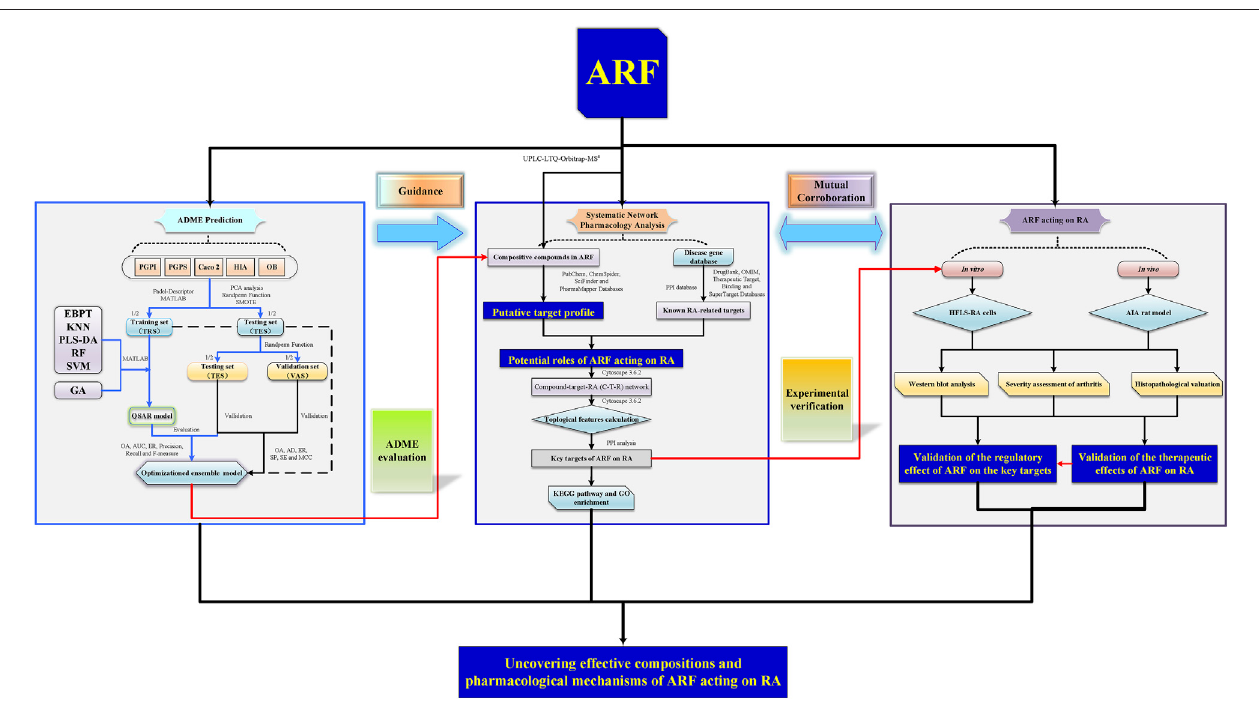
FIGURE1| AschematicpictureofthewholedevelopmentstrategiesinunravelingthepharmacologicalmechanismsofARFderivedfromDianbaizhuintreatingRA. FortheADMEpredictionsection,thebluesolidarrowsrepresentthemodelingprocessoftheQSARmodels,andtheblacksolidlineanddottedlinearrowsrepresentthe evaluation and validation processes of the models. Forthe other parts, the black solid arrows stand for process transition. The red solid arrows re fl ect the relevance and progressiveness among the three portions.